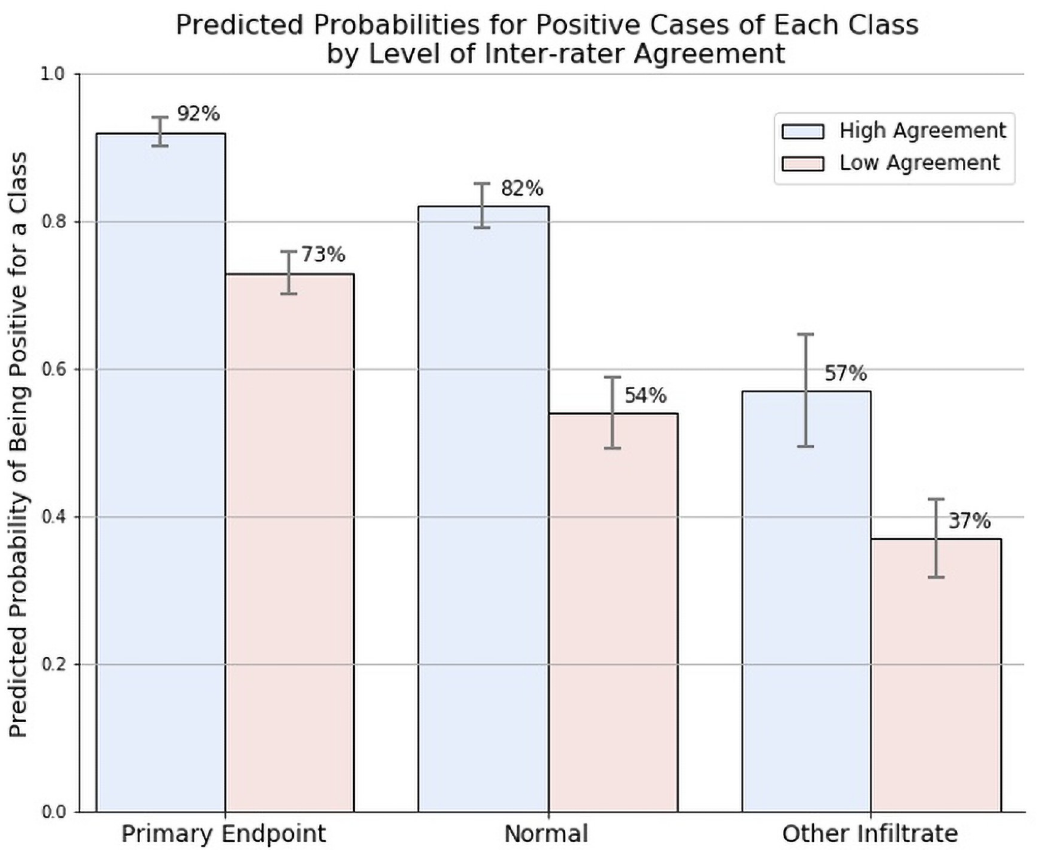
Fig 1. Comparison of model predicted probabilities and 95% confidence intervals by endpoint and level of human reader agreement.